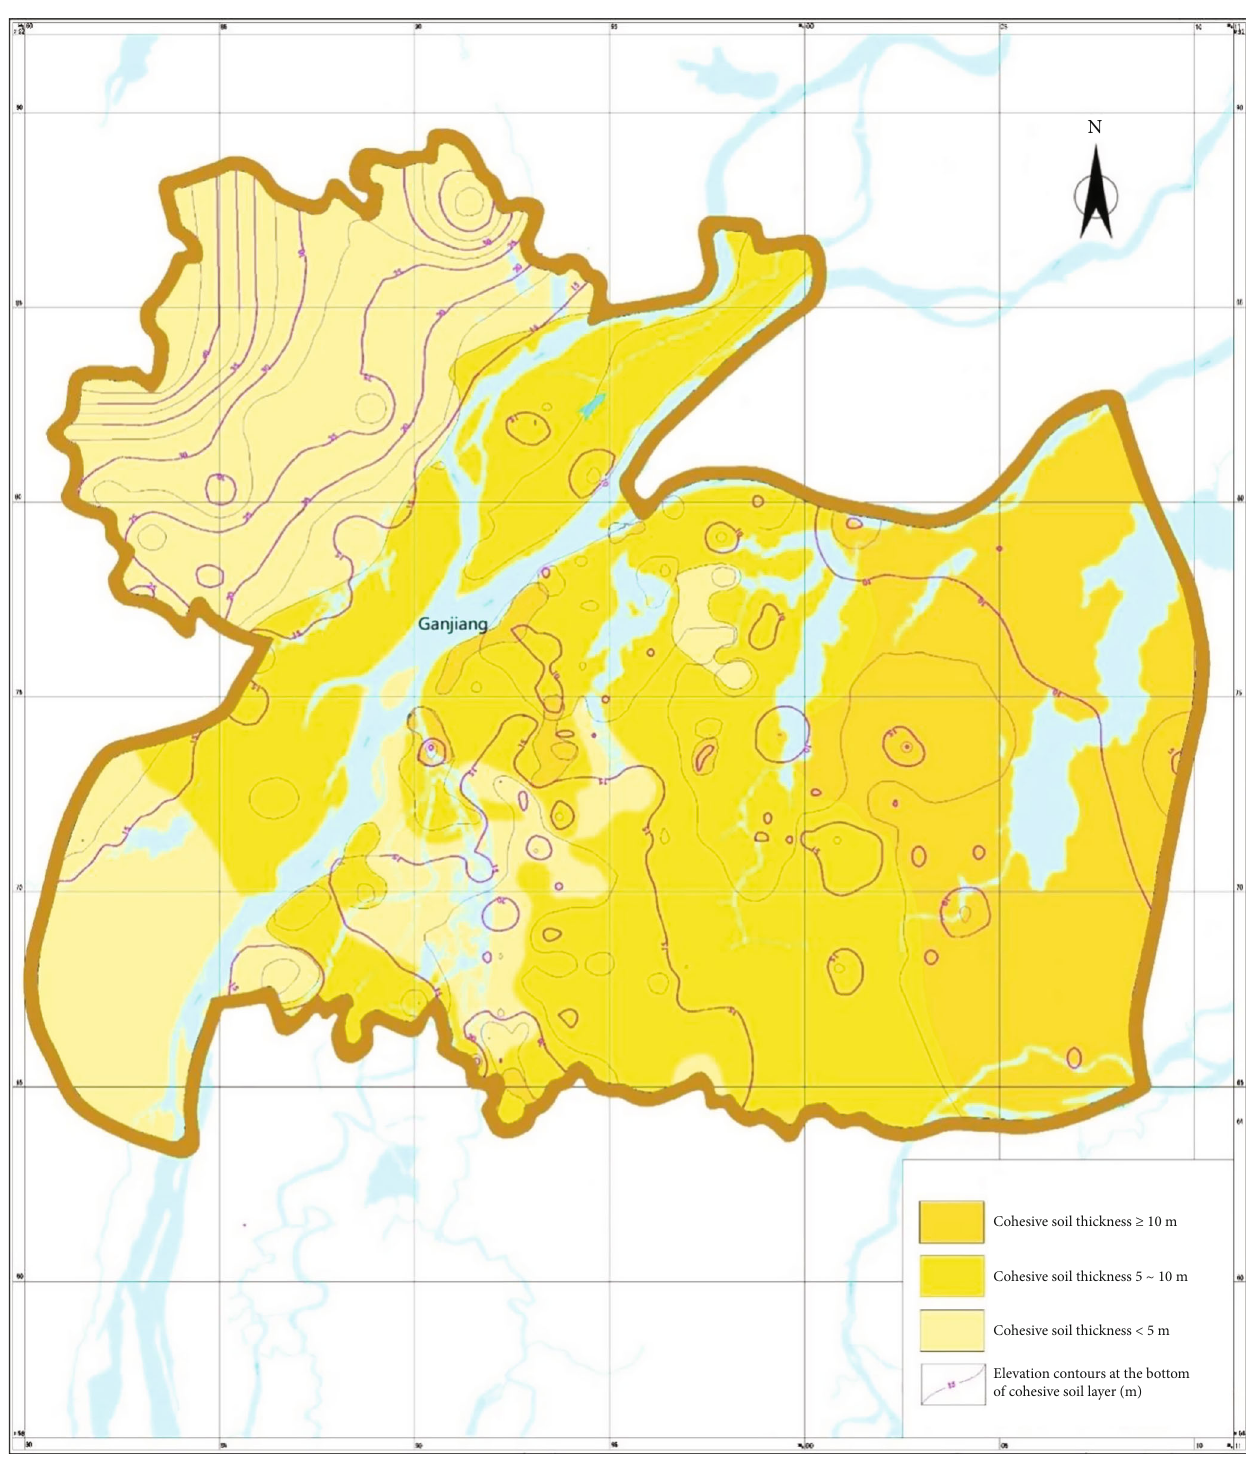
Figure 1: Zoning map of the overlying cohesive soil